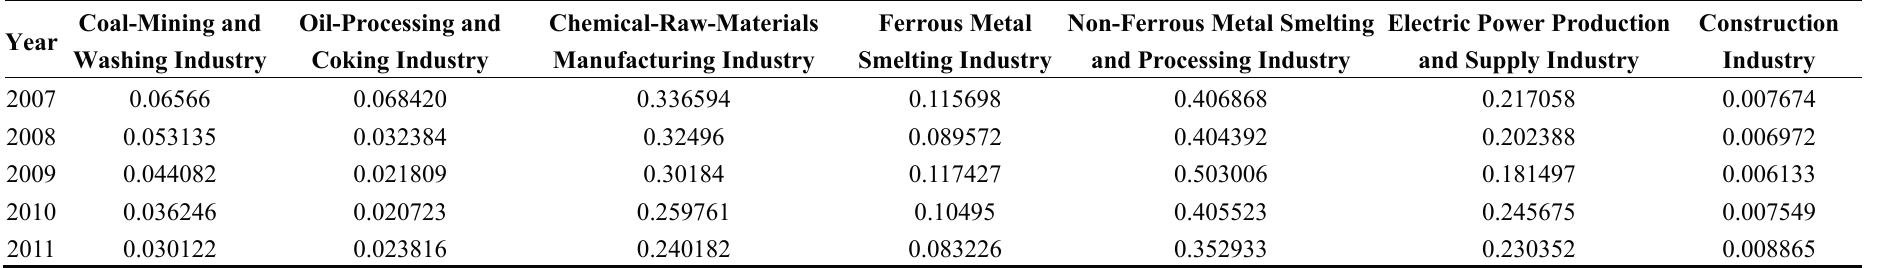
Table 15. The power needed per 10 thousand yuan of industries in Shanxi Province from 2007 to 2011 (10 thousand Kwh).